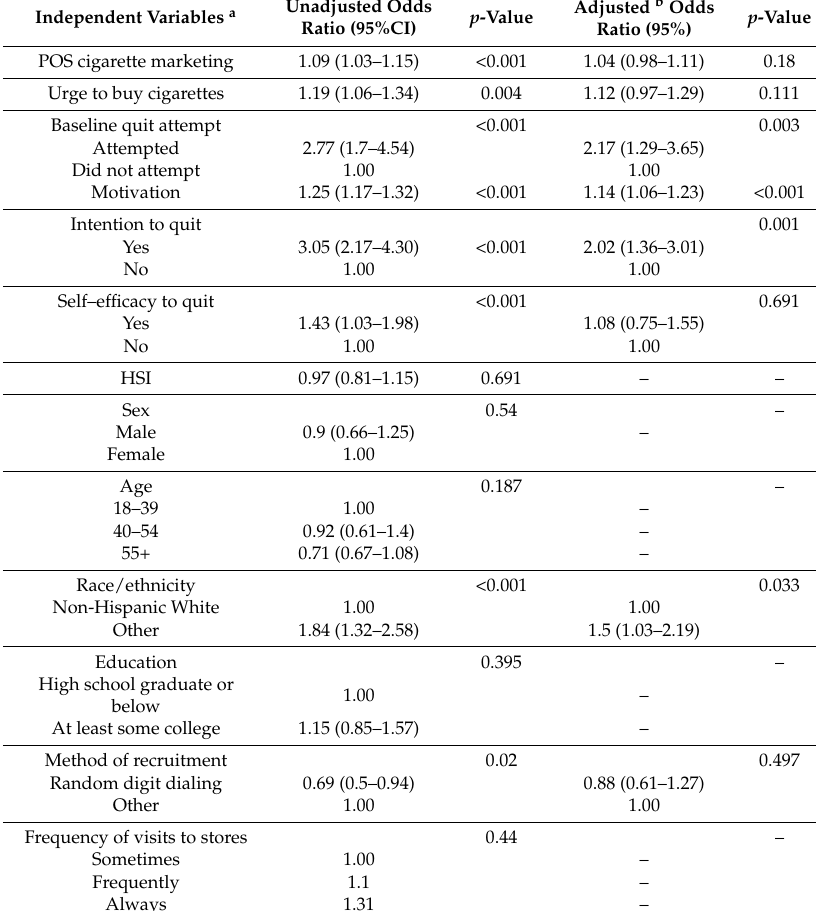
Table 2. Logistic regression results for the effect of exposure to point-of-sale (POS) cigarette marketing and other independent variables on the odds of making a quit attempt ( n =